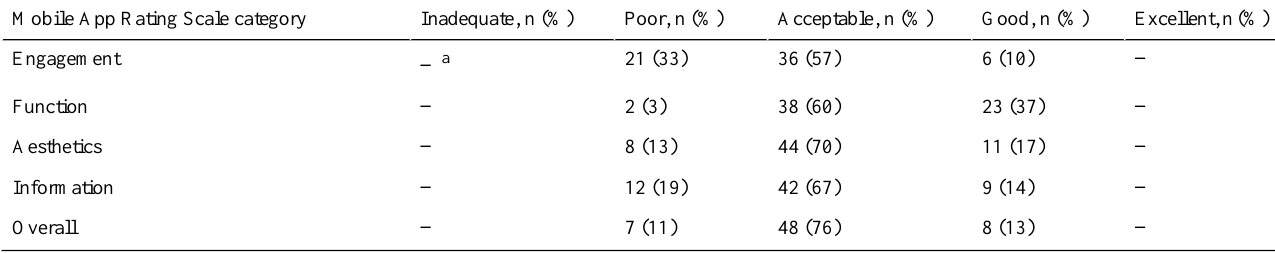
Table 2. Classification of mental health apps according to the mean Mobile App Rating Scale scores